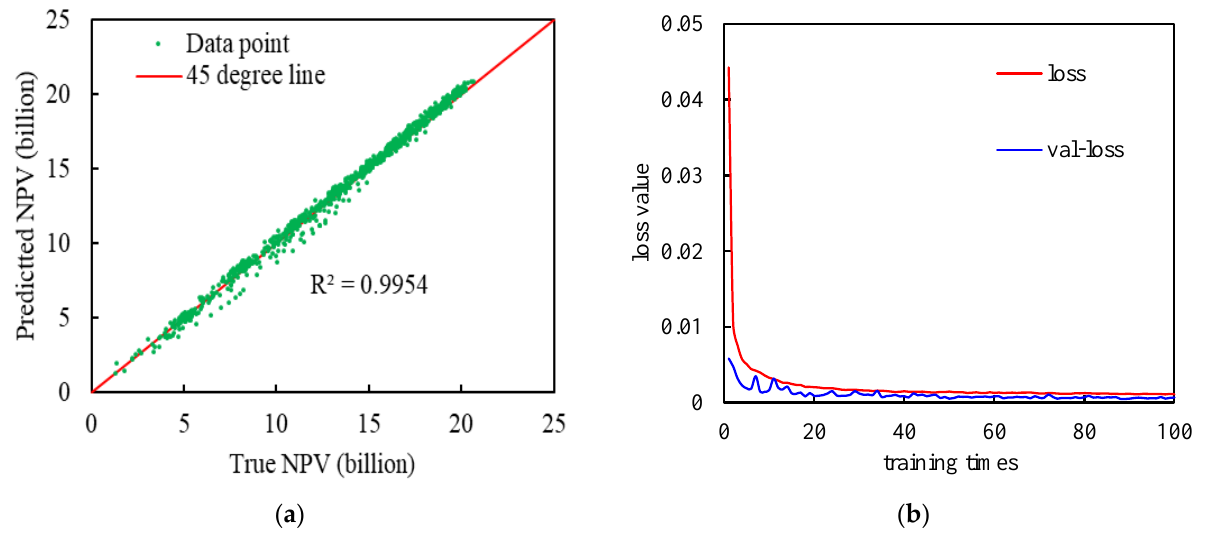
Figure 7. Comparison of ( a )The cross plot of predicted versus true NPV based on the Deep-LSTM model (test set training effect) and ( b ) Loss function value changes during training.